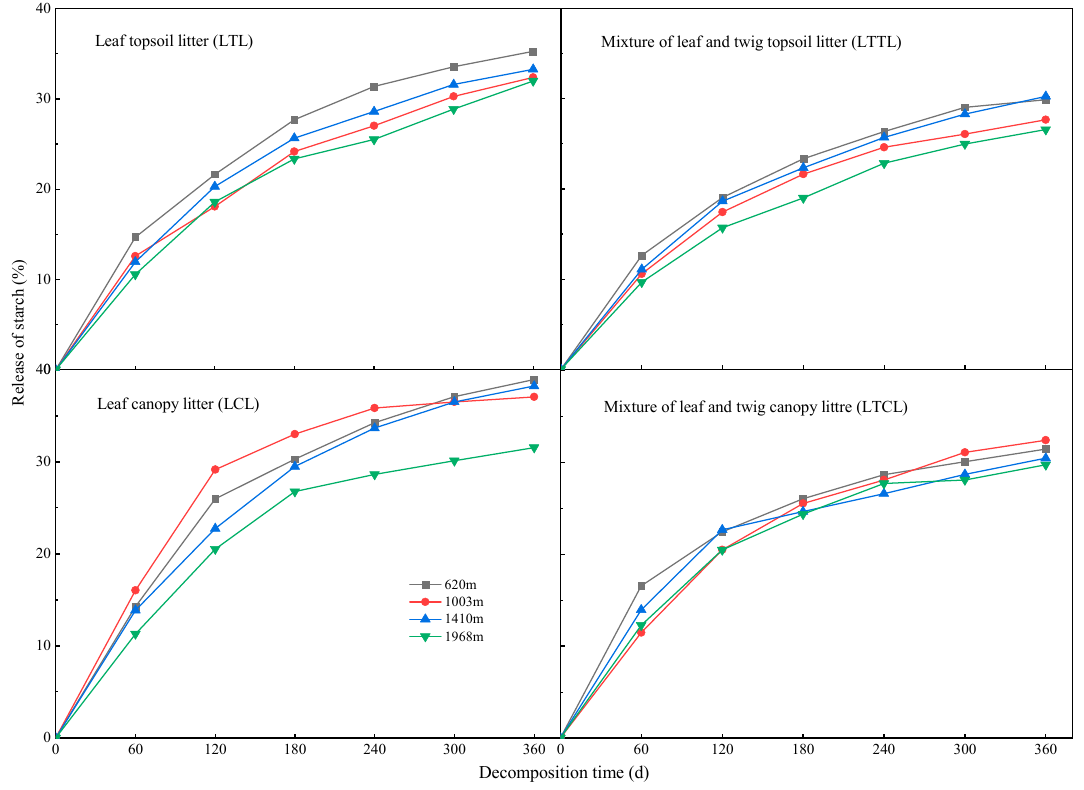
Figure 2. Cumulative release of starch in Chinese fir topsoil litter and canopy litter at different altitudes.